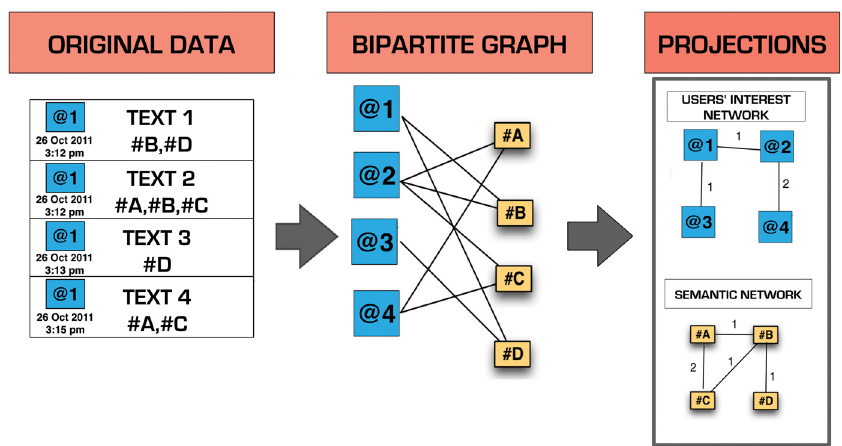
Fig 1. Schematic representation of the bipartite graph construction from raw data and of the projections on the semantic and interest mono-partite graphs.